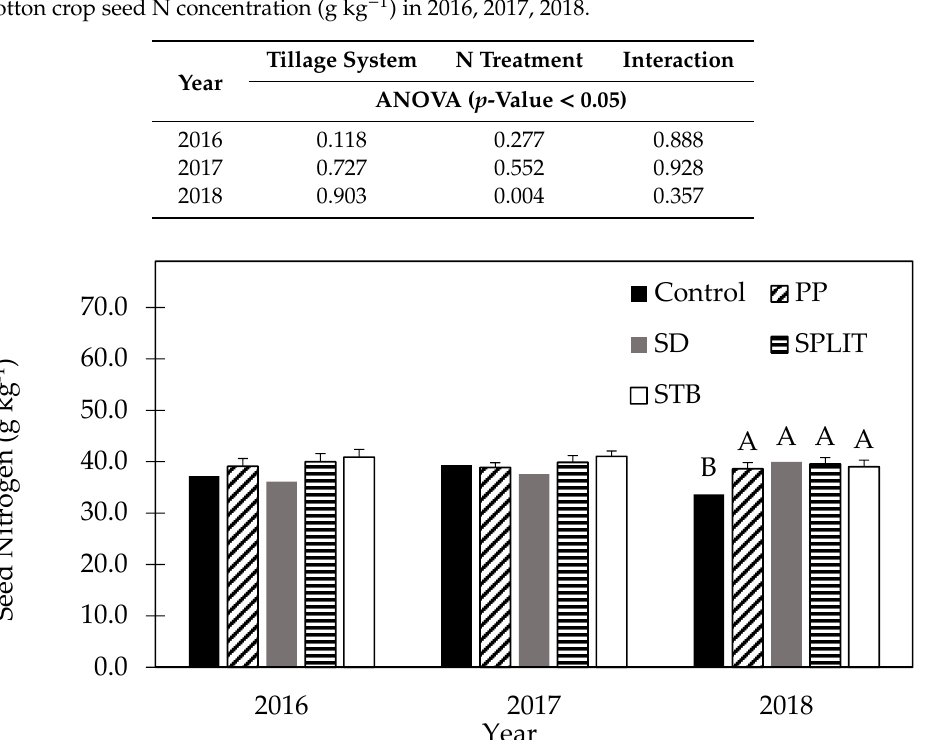
Figure 4. Cotton seed nitrogen (N) concentration (g kg-1) for nitrogen (N) treatments averaged across tillage systems in 2016, 2017, and 2018. Control, 0 added N fertilizer; PP, 100% preplant; SD, 100% side-dressed; SPLIT, 40% preplant, 60% side-dressed; STB, 100% preplant with N stabilizer. LSD letters are compared within year across N treatment and are significant at p < 0.05.